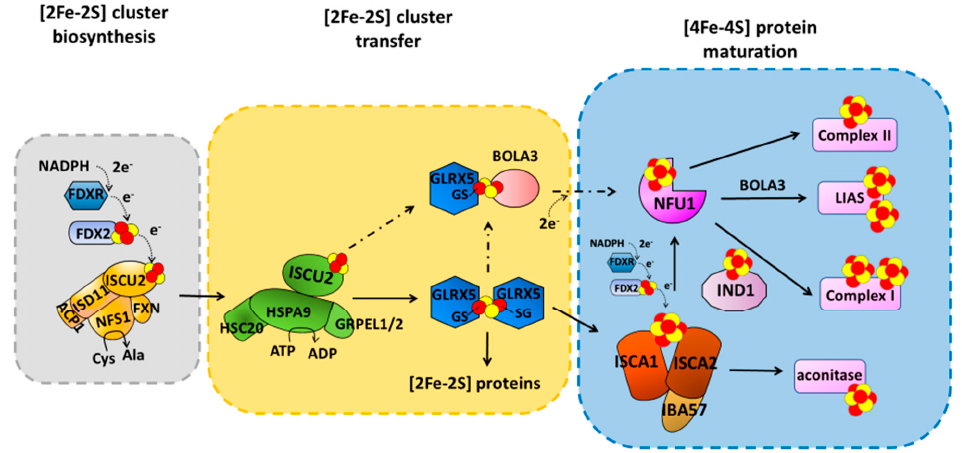
Figure 1. The three steps of the mitochondrial iron–sulfur cluster assembly machinery required to mature mitochondrial [4Fe-4S] target proteins. In the first step, a [2Fe-2S] cluster is assembled de novo on the scaffold protein ISCU2. The biosynthesis involves six additional ISC proteins including the cysteine desulfurase complex NFS1-ISD11-ACP1 as a sulfur donor, frataxin (FXN), and the electron (e − ) transfer chain from NADPH via ferredoxin reductase (FDXR) to ferredoxin FDX2. Only one half of the symmetric core ISC complex is depicted. In the second step, a dedicated chaperone system (HSPA9, HSC20, and GRPLE1/2) facilitates the transfer of the [2Fe-2S] cluster from the ISCU2 scaffold to the monothiol glutaredoxin GLRX5, which binds the cluster in glutathione (GS)- dependent fashion. A secondary route (indicated by dashed arrows) involves BOLA3, which forms an apo complex with GLRX5 able to receive a [2Fe-2S] cluster from ISCU2 to form the homodimeric [2Fe-2S] GLRX5 complex; or, alternatively, the latter complex can be formed via the interaction of BOLA3 with the homodimeric [2Fe-2S] GLRX5 complex. The third step involves [4Fe-4S] cluster synthesis and apoprotein insertion. GLRX5 delivers its [2Fe-2S] cluster to three late-acting ISC proteins (ISCA1, ISCA2, and IBA57) for [4Fe-4S] cluster biosynthesis, which additionally requires the ferredoxin FDX2 electron transfer chain. Subsequently, the newly formed [4Fe-4S] cluster is delivered to recipient apoproteins by dedicated Fe-S-targeting proteins (e.g., NFU1, IND1 directly binding the [4Fe-4S] cluster) via parallel pathways. The major role of BOLA3 protein is in lipoyl synthase (LIAS) maturation. BOLA3 might be involved in such function via an alternative pathway, which consists on the [2Fe-2S] cluster donation from [2Fe-2S] GLRX5-BOLA3 complex to apo NFU1 to assemble a [4Fe-4S] cluster on NFU1 thanks to the delivery of two electrons, whose physiological source needs, however, to be